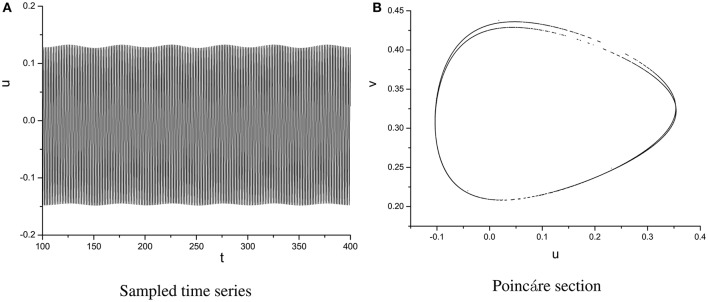
Sampled time series (A) and its Poincáre section (B) as ω = 4.0.